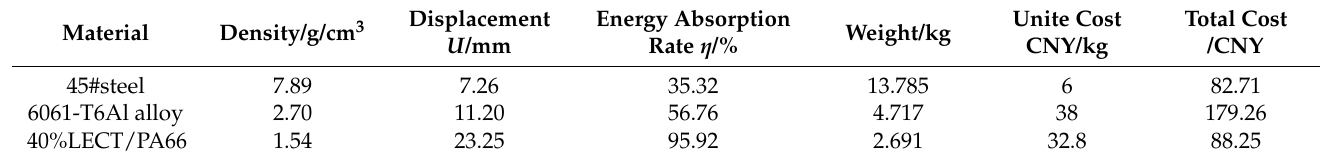
Figure 8. Comparison of energy absorption curves of competing materials. Table 4. Comparison between car bumper beams made of different